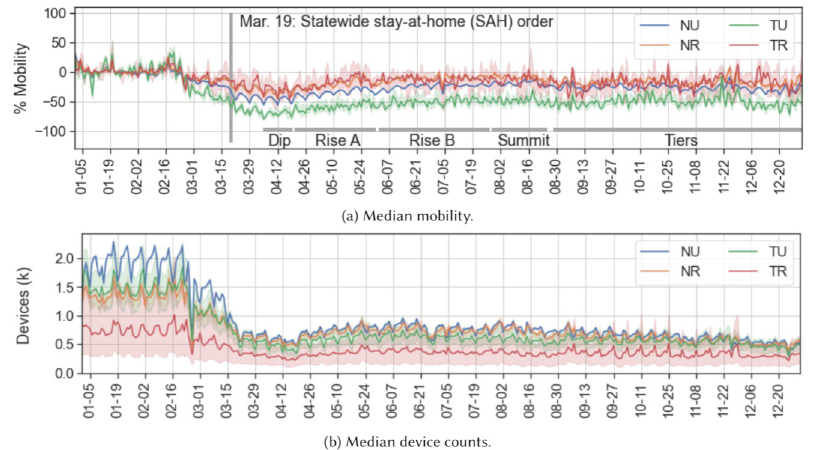
Fig 10. Daily median mobility and device counts seen in each cluster category in SoCal through 2020. Tick marks show every two weeks starting with the first Sunday in January. Ribbons in both (a) and (b) indicate the 5 th –95 th percentile values of all BGs for each day. Significantly, although device counts in (b) initially diminish in the Dip, they do not track the steady return to baseline seen in mobility in (a) throughout the year.